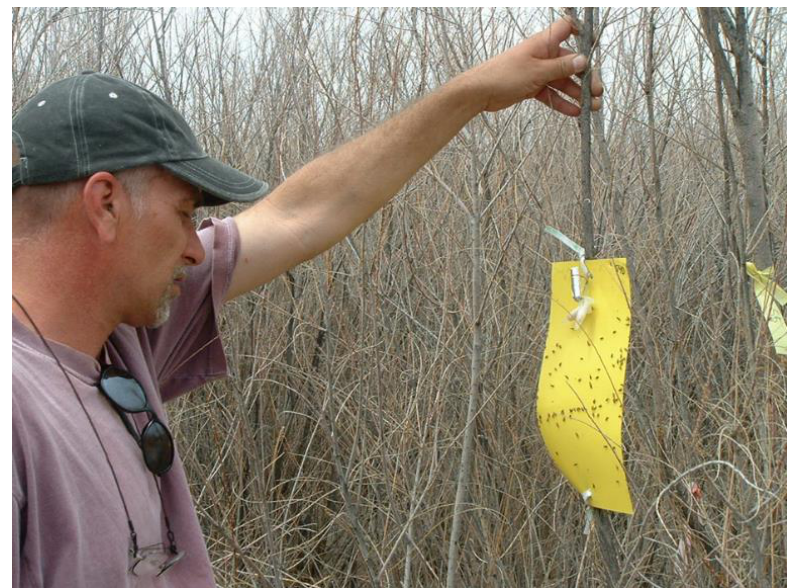
Figure 3. Yellow sticky cards baited with the antennally active compounds, D. carinulata pheromone blend + green leaf volatiles, as part of a field trial conducted in western Nevada on 5 April 2004. Attraction of adult beetles to the cards was the measure of semiochemical activity of the volatile compounds. Allard Cossé, chemical ecologist with the USDA ARS, is here seen checking the trap as part of a cooperative effort between USDA ARS chemists and biocontrol practitioners [15,16].